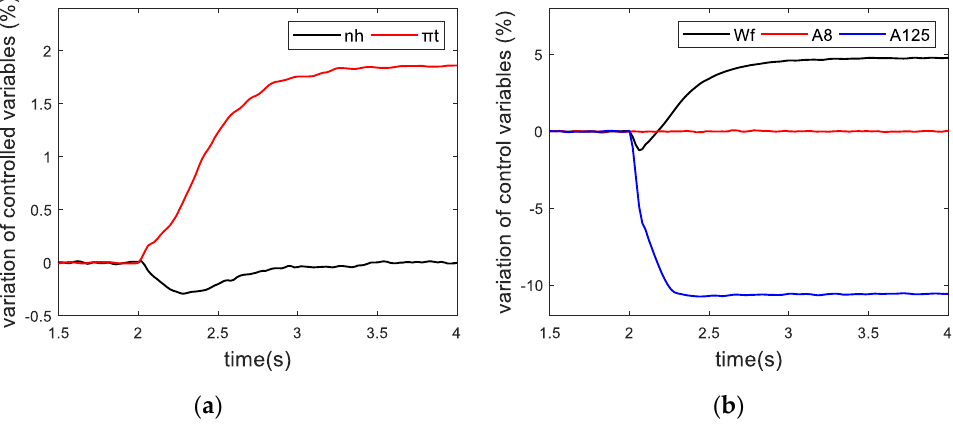
Figure 14. FTC result of ASMC design in HIL test. ( a ) controlled variables ( b ) control variables.